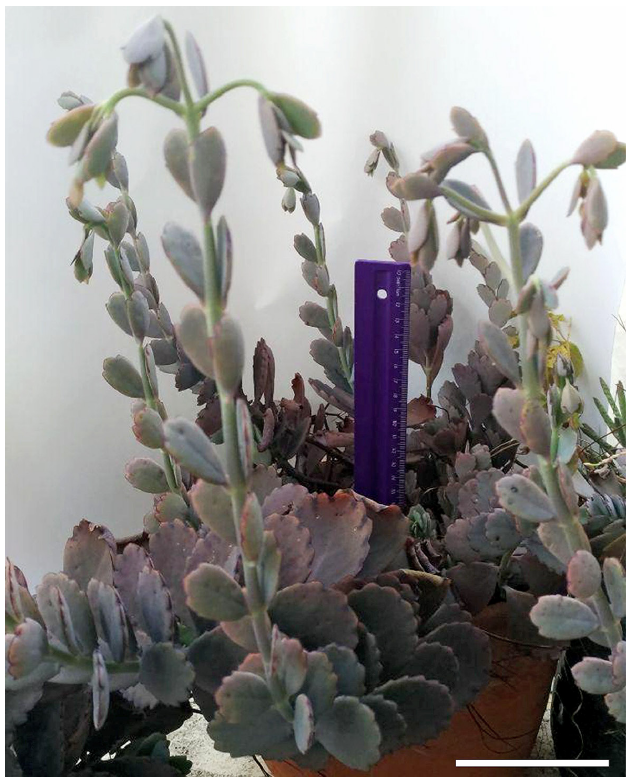
Fig. 1: Kalanchoe fedtschenkoi R. Hamet & H. Perrier. Bar 10 cm.